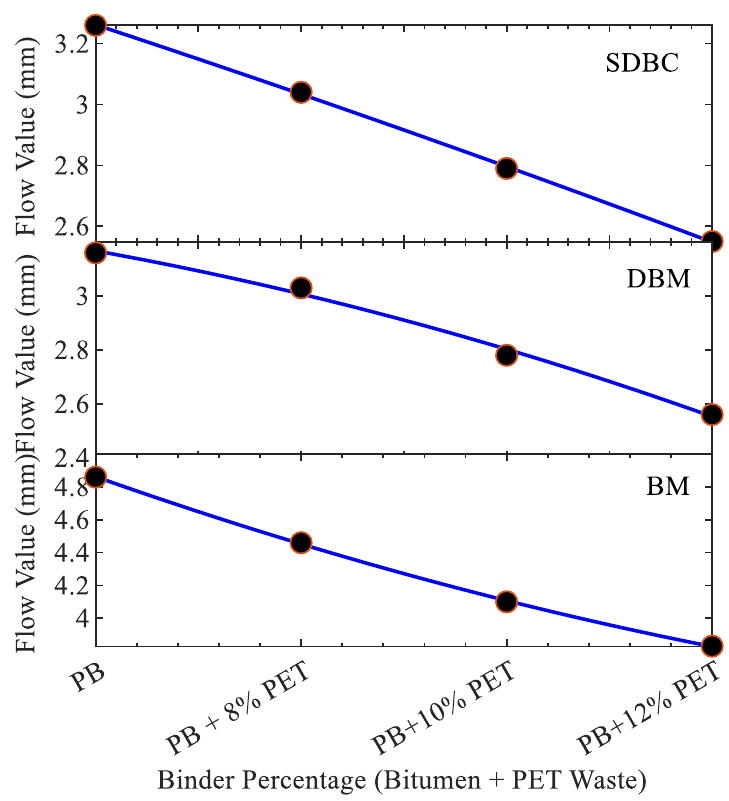
Fig. 25 Relations between Marshall flow value and binder content for modified SDBC, DBM, and